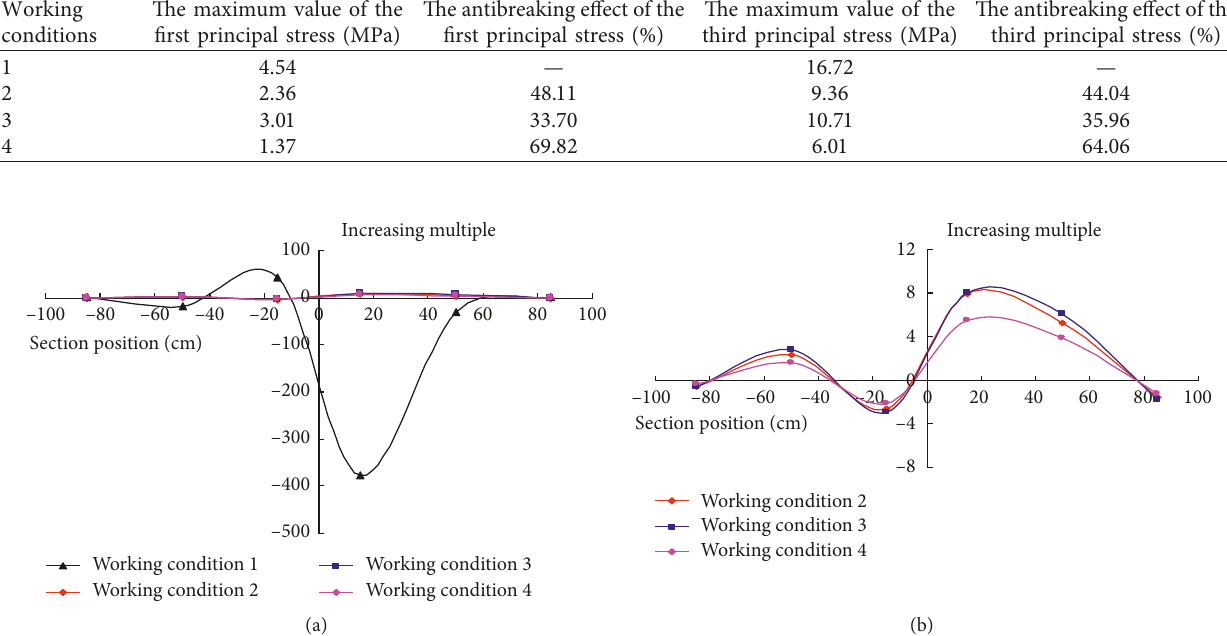
Figure 7: Increasing multiple of longitudinal strain. (a) Working conditions 1 to 4. (b) Working conditions 2 to 4.